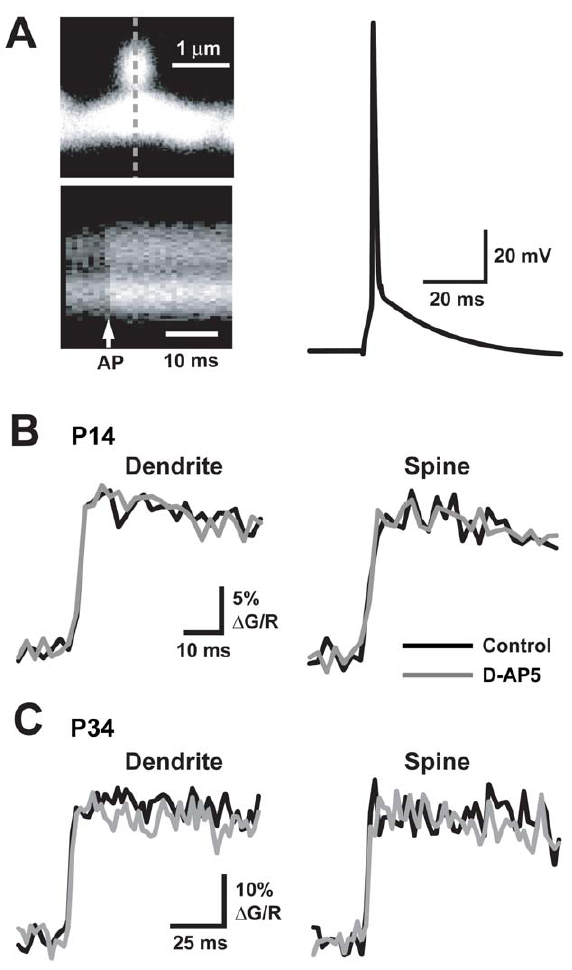
Figure 1. NMDAR antagonism has no differential effect on bAP-evoked Ca 2 + signals in dendrites or spines. A. Top left: 2PLSM image of a spine and dendrite with dashed line indicating line scan position. Bottom left: During a 500 Hz line scan through spine and dendrite, a bAP (arrow) evokes a Ca 2 + transient in both compartments. Right: Somatic AP evoked by current injection. B, C. Average Ca 2 + transients evoked by a bAP measured in the dendrite (left) and spine (right) from a P14 animal (B; n=11 for both structures) and a P34 animal (C; spine, n=17; dendrite, n=13) in the presence and absence of D-AP5 (10–50 m